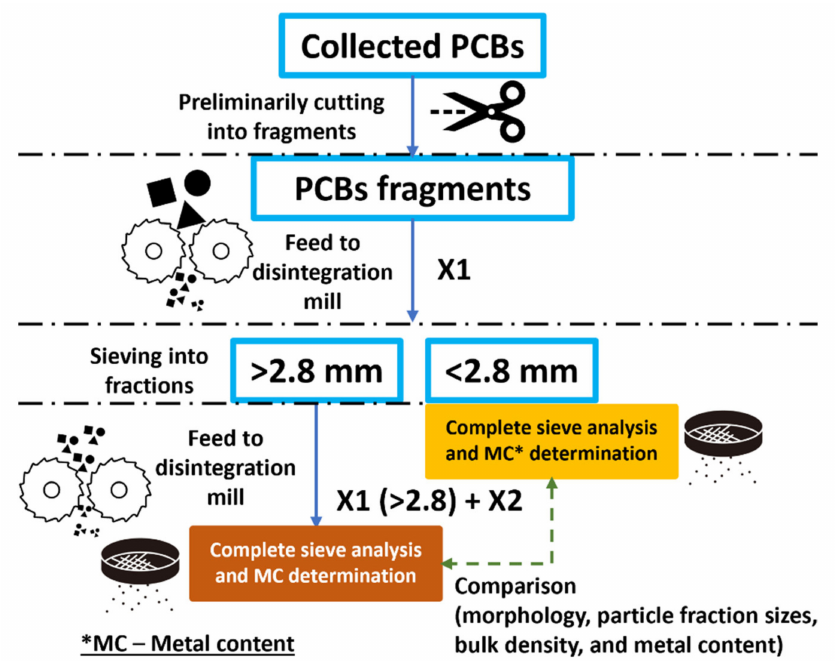
Figure 3. An applied disintegration–milling, sieving, and testing scheme show an approach for selecting fractions of powders from PCBs for metal content determination after one-step (X1) and double-step (X1 (>2.8) + X2)